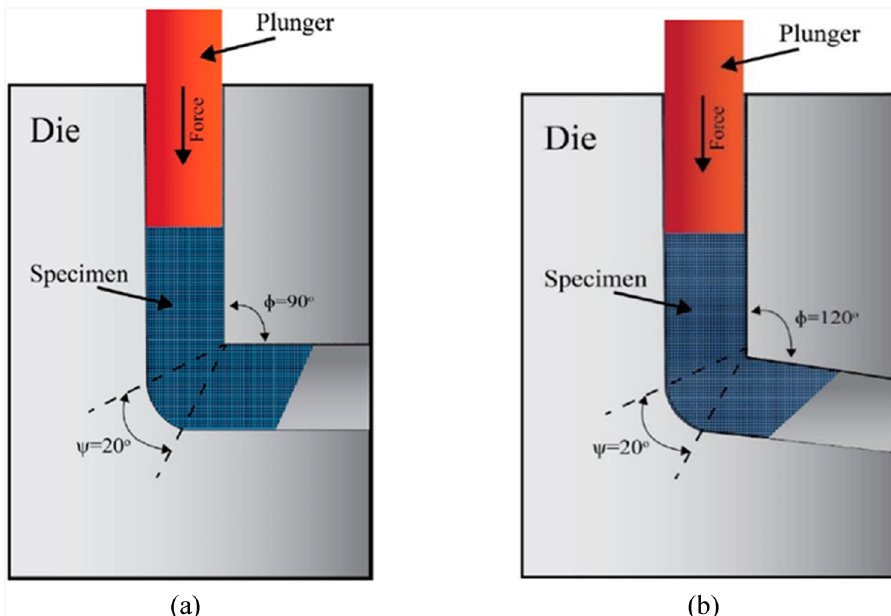
Figure 2: Schematic of the ECAP dies with internal channel angle of ( a ) 90° and ( b )